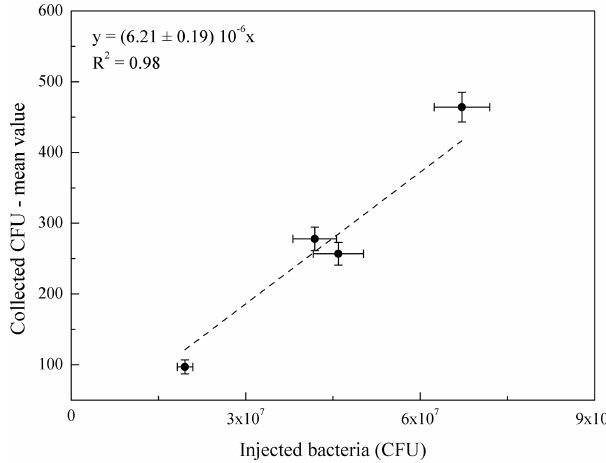
Figure 4. SLAG nebulization efficiency (percentage values) vs. up- stream air flow. Liquid feed rate = 0.4mLmin − 1 .